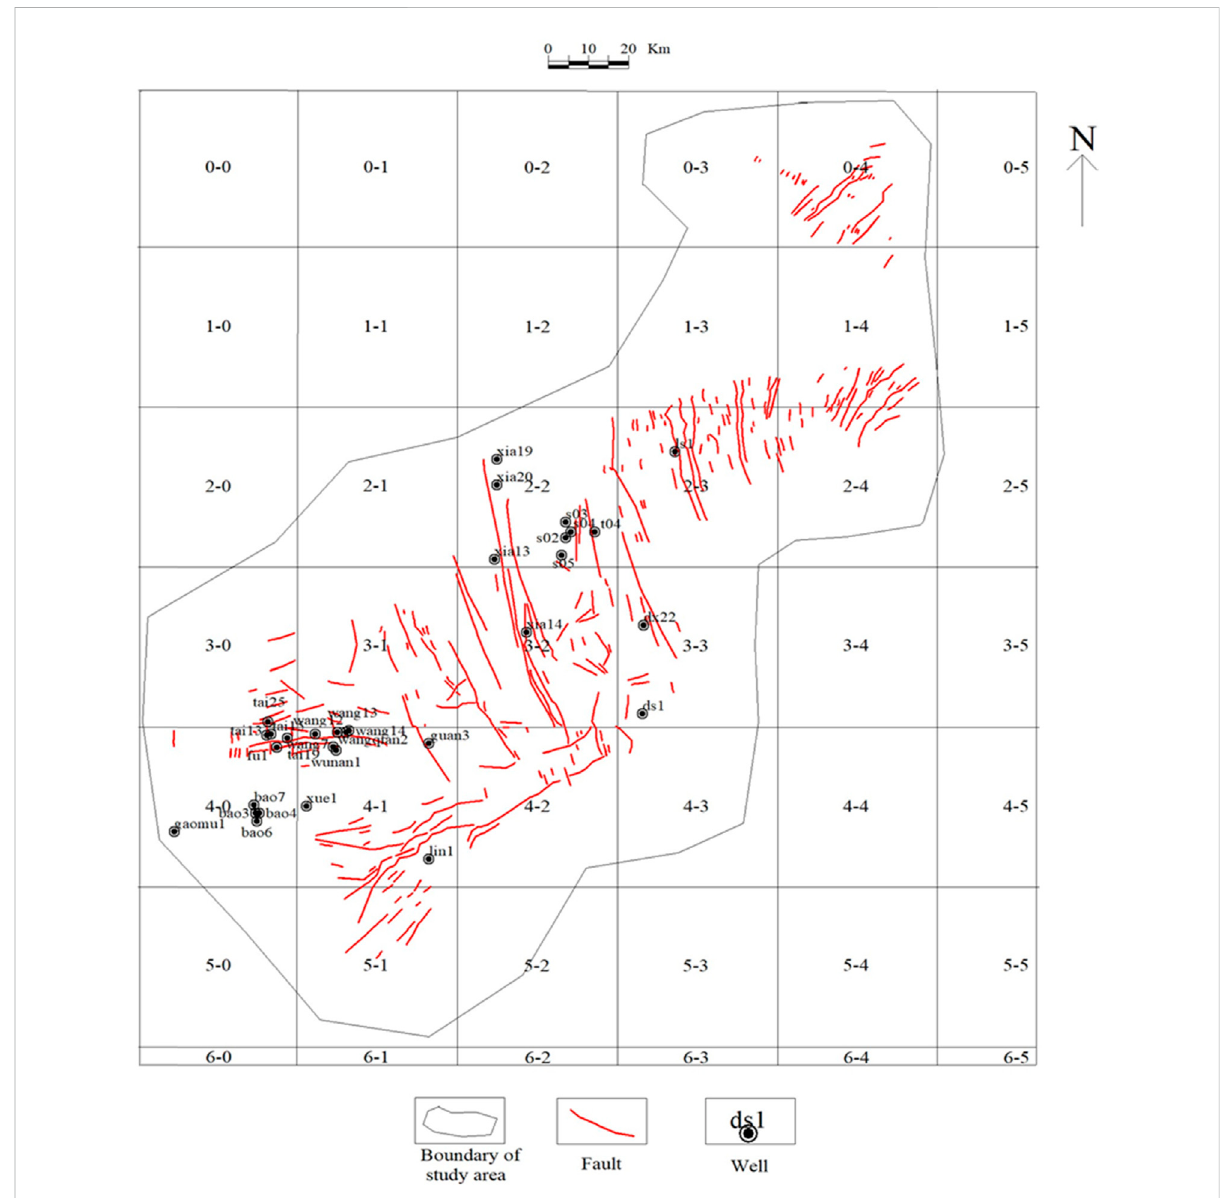
FIGURE 3 Fault distribution map of Maokou Formation in southeast Sichuan (modi fi ed from Hu et al.,